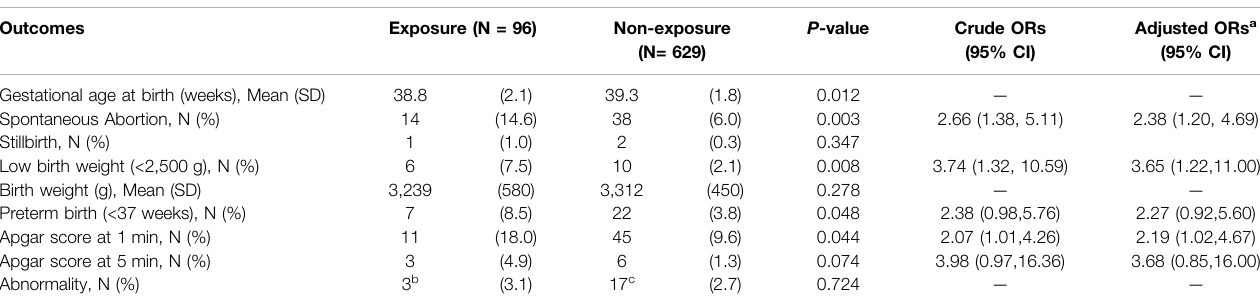
TABLE 3 | Pregnancy and neonatal